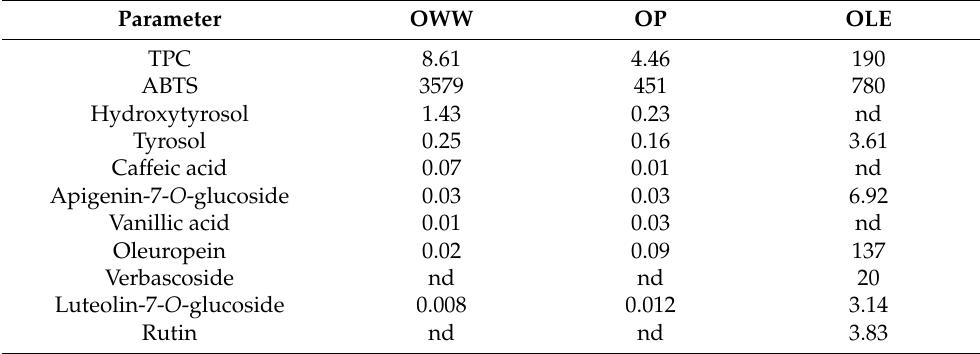
Table 1. Total phenol content (TPC, mg GAE mL − 1 for OWW and OP; mg GAE g − 1 for freeze-dried OLE), antioxidant activity ( µ mol TE mL − 1 for OWW and OP; µ mol TE g − 1 for OLE) and phenolic profile (mg · mL − 1 for OWW and OP; mg · g − 1 for OLE) of phenolic extracts. Parameter